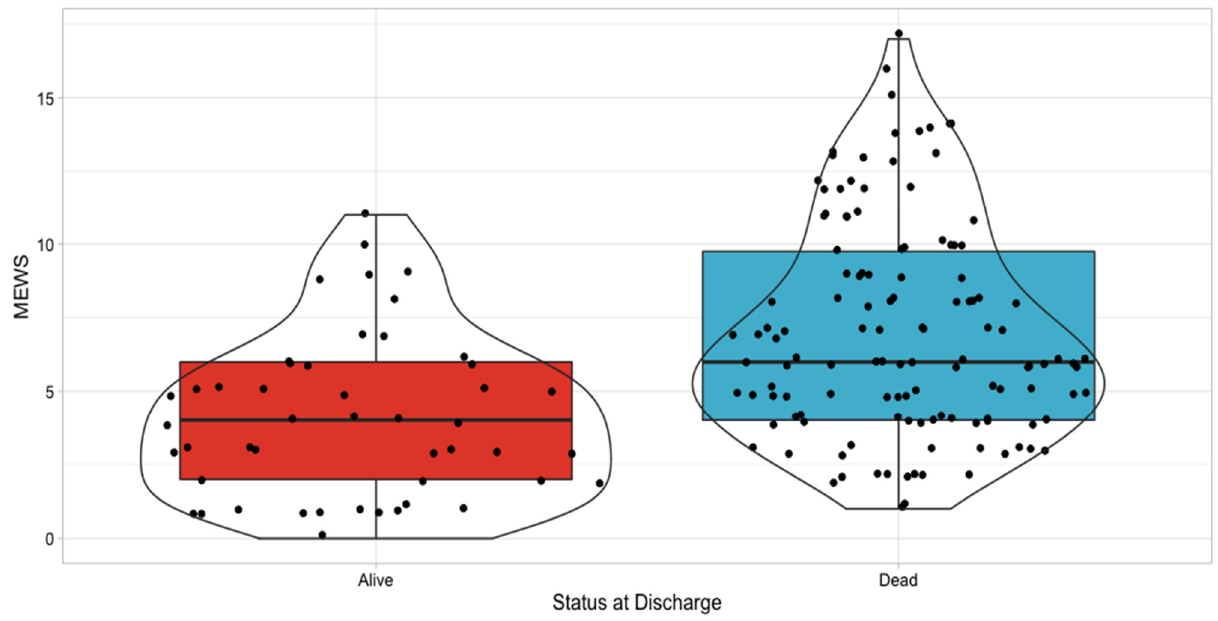
Figure 1. MEWS values considering the status at discharge.